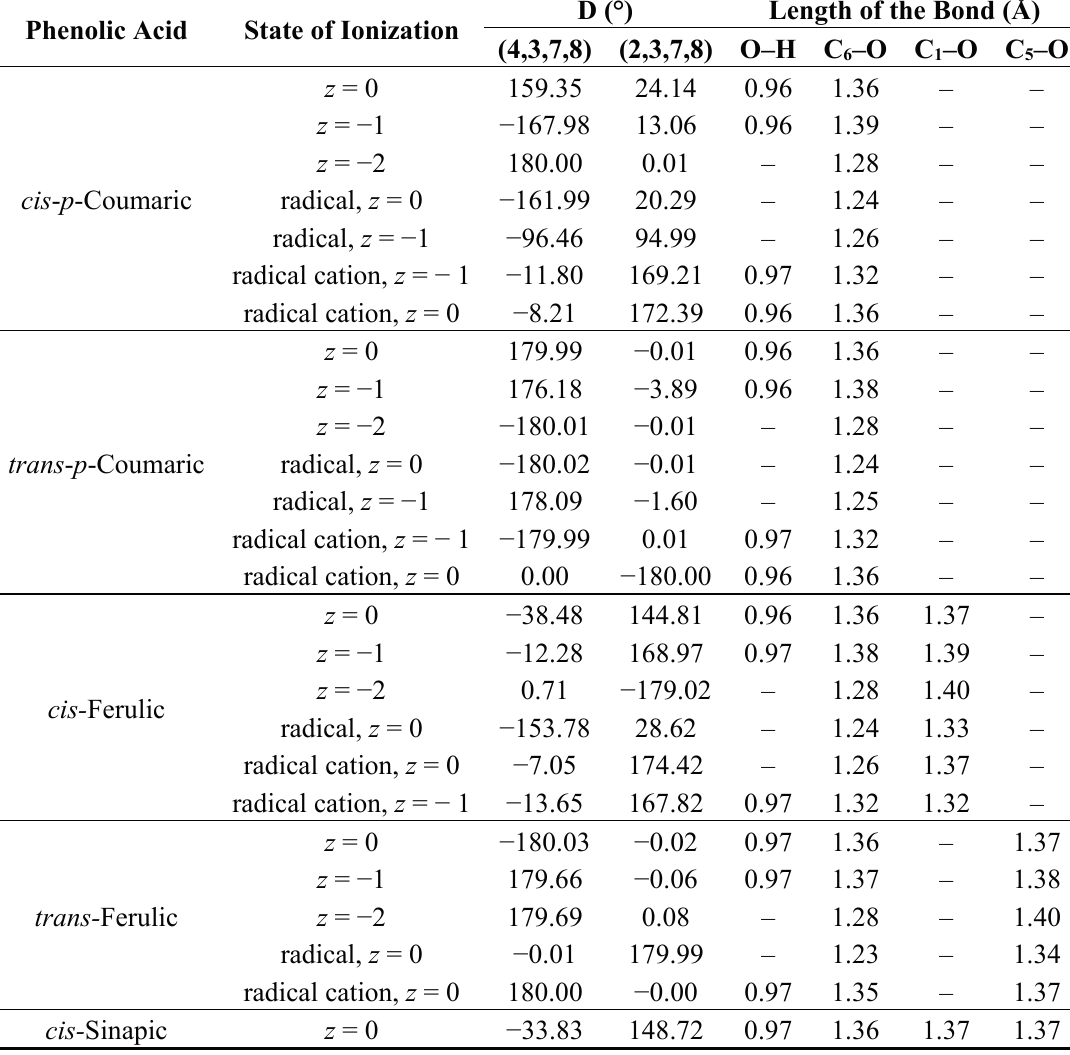
Table 5. Geometry parameters of HC acid molecules and corresponding radicals and radical cations in various states of ionization. Atom numbering according to Figure